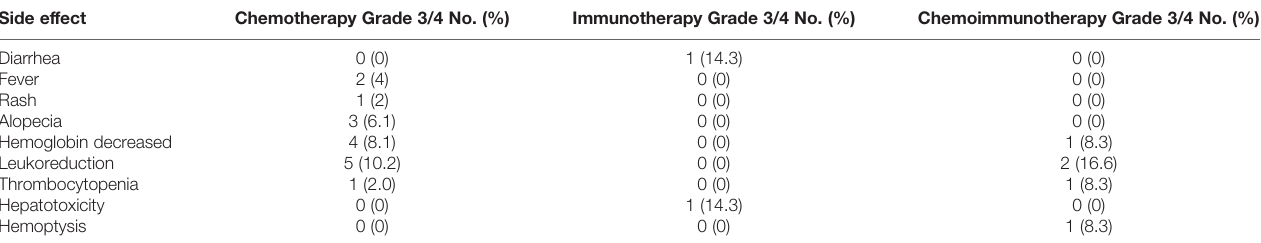
TABLE 2 | Treatment-related grade 3/4 adverse events of three groups.